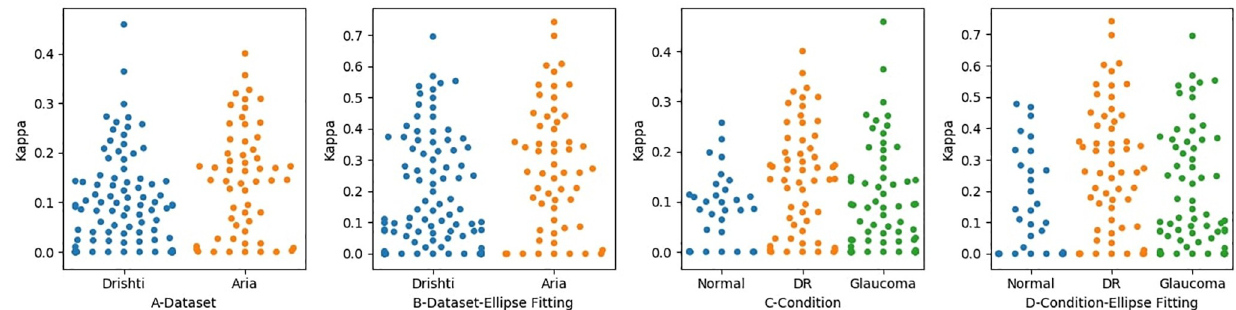
Fig 7. The level of agreement between the optometrists when identifying disc region. Figures A and B Show the Level of Agreement in each Dataset. Figures C and D show the Level of Agreement in Regard to Retinal